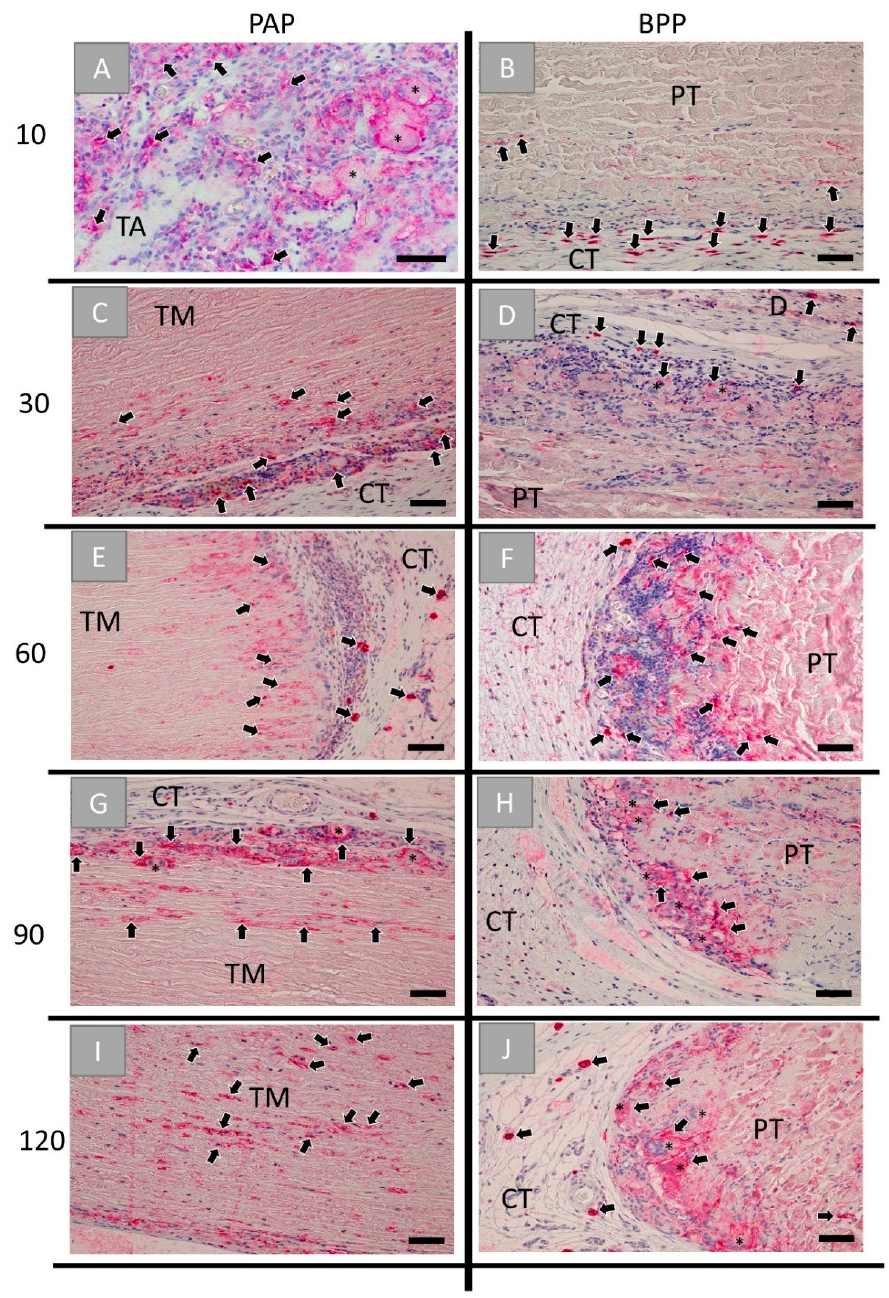
Figure 6. Histological images of the immunohistochemical detection of pro-inflammatory cells within the implantation beds of the porcine aorta patch (PAP, left row) and the bovine vessel patch (BPP, right row) at ( A , B ) day 10, ( C , D ) day 30, ( E , F ) day 60, ( G , H ) day 90 and ( I , J ) day 120 post implantationem within the subcutaneous connective tissue (CT). Black arrows: CD11c-postive macrophages, black asterisks = CD11c-positive MNGCs, TM: tunica media, PT: pericardial tissue, D: dermis (immunohistochemical CD11c-stainings, 20 × magnifications, scale bars = 50 µ